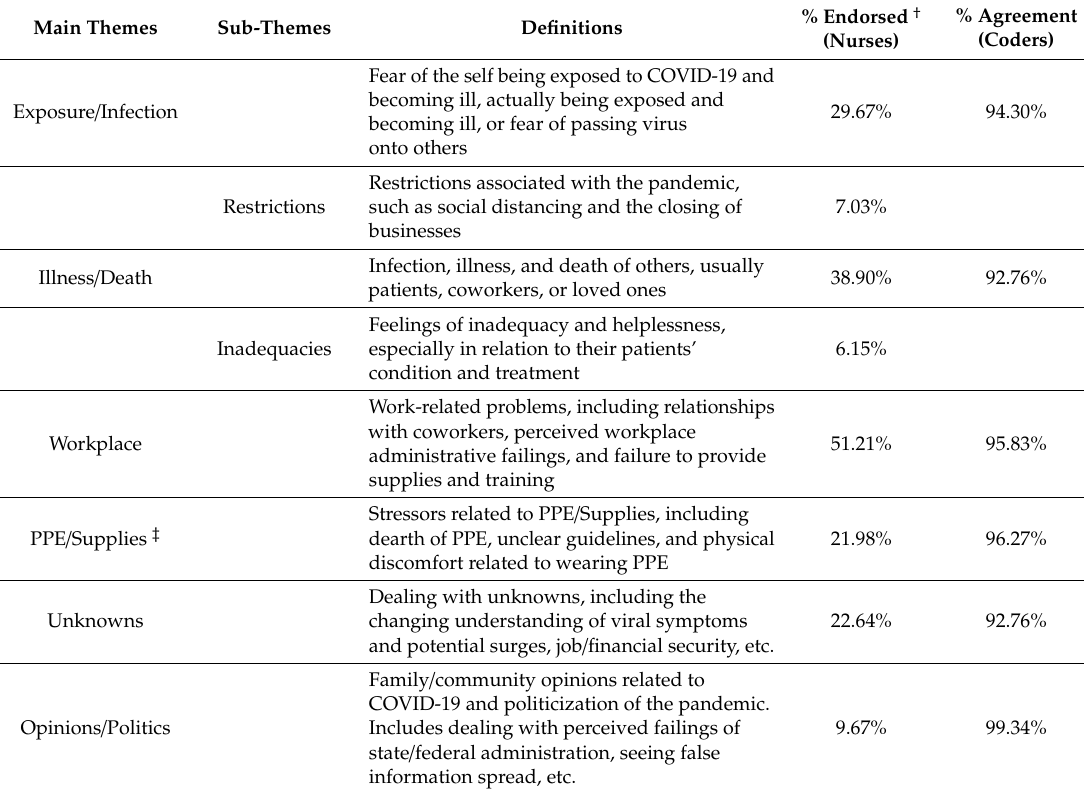
Table 1. Overview of main themes and